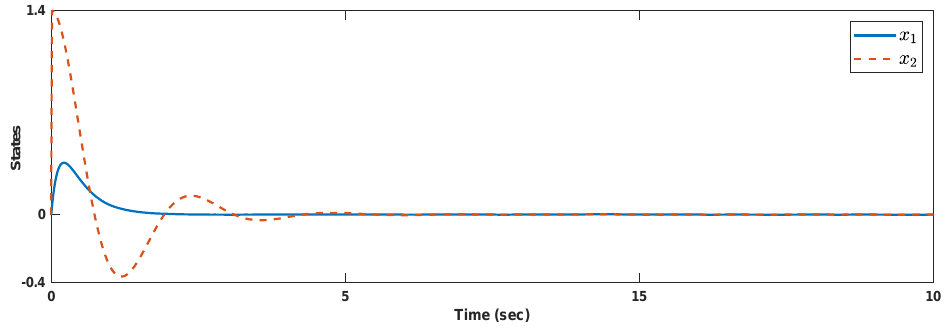
Figure 9. Example 4: Output